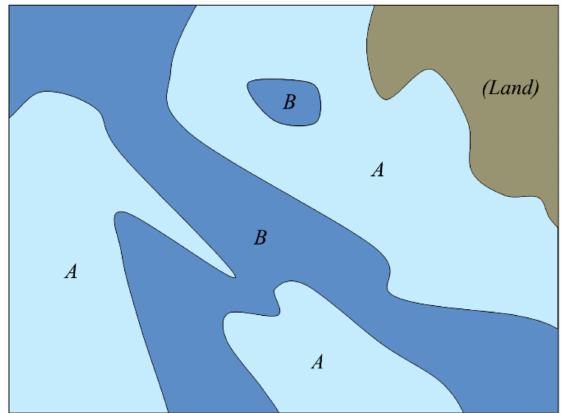
Figure 6. Real seabed topography, A represents the clear shallow water area, and B represents the deep turbid